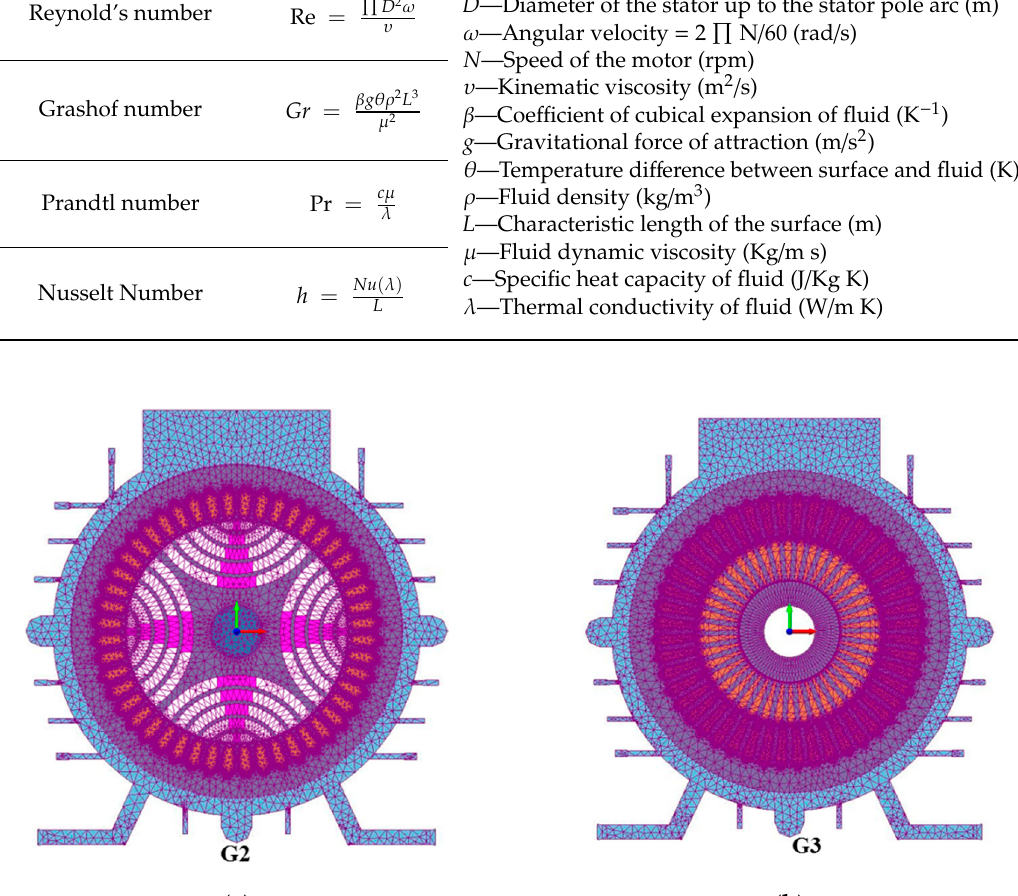
Figure 10. Mesh region with outer frame for ( a ) G2 and ( b ) G3.